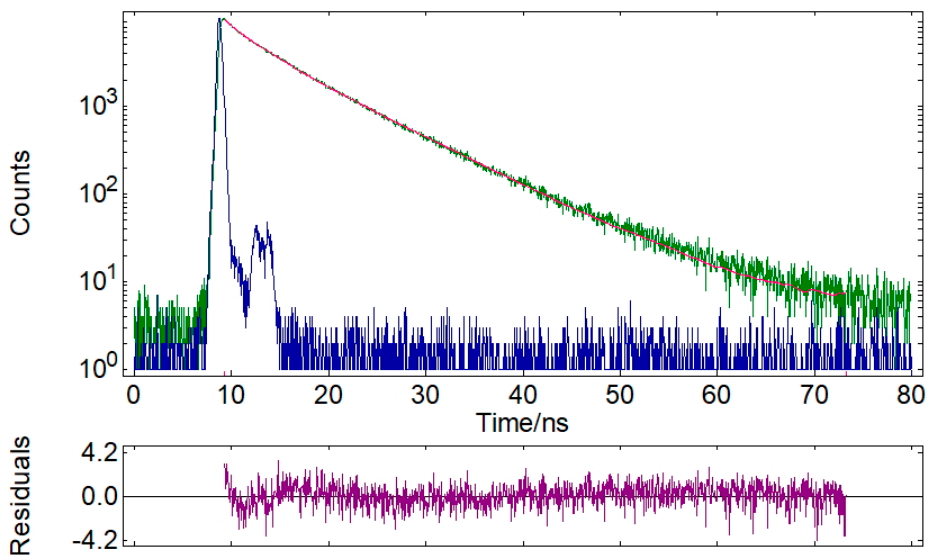
Figure A2. Time − resolved fluorescence lifetime decay profile of solid powder 32 (green), instrumen- tal response function (IRF, blue). λ ex = 375 nm and λ em = 504 nm.